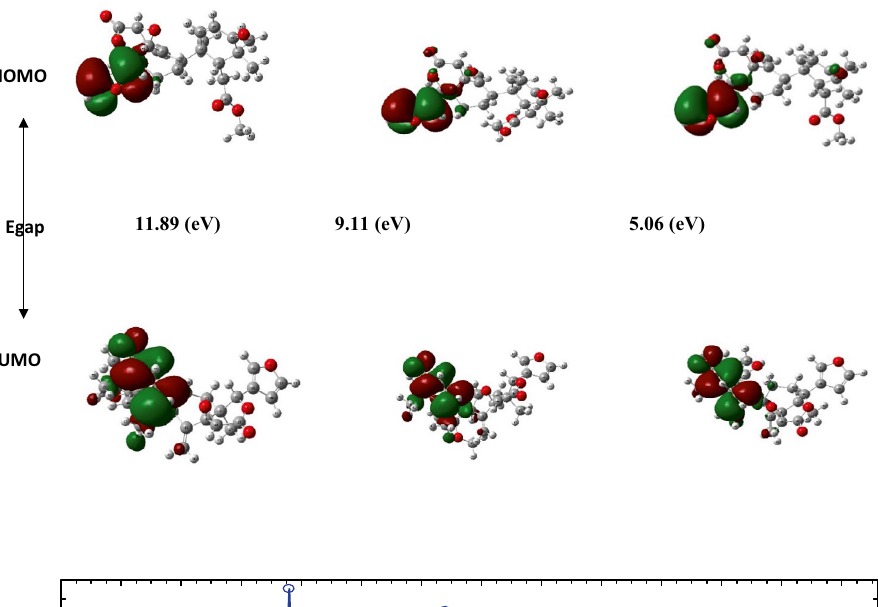
Fig. 11 Analysis of the atomic charge of